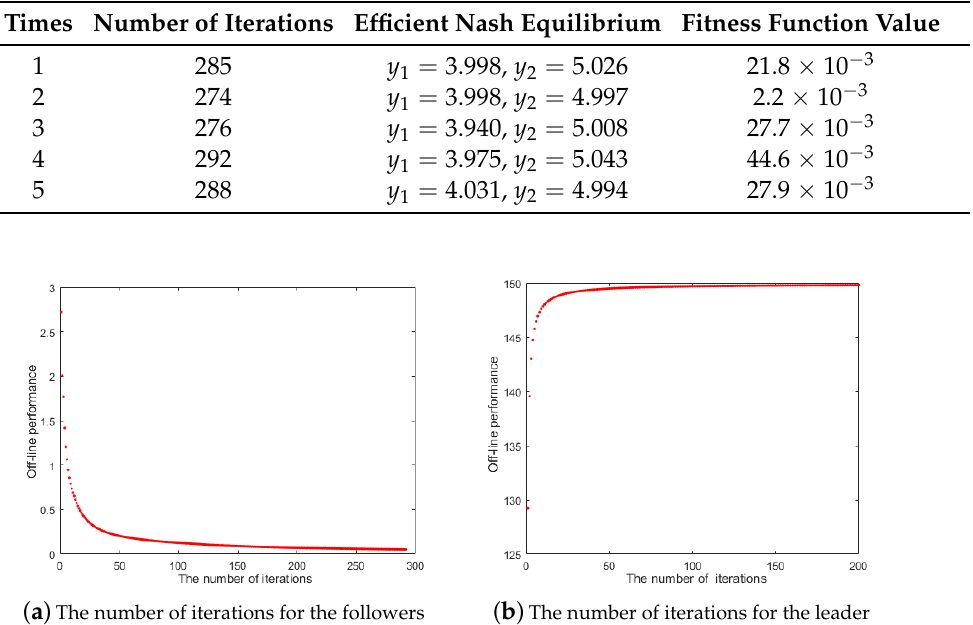
Table 1. The IPSO algorithm for solving the followers’ result of Example 1.